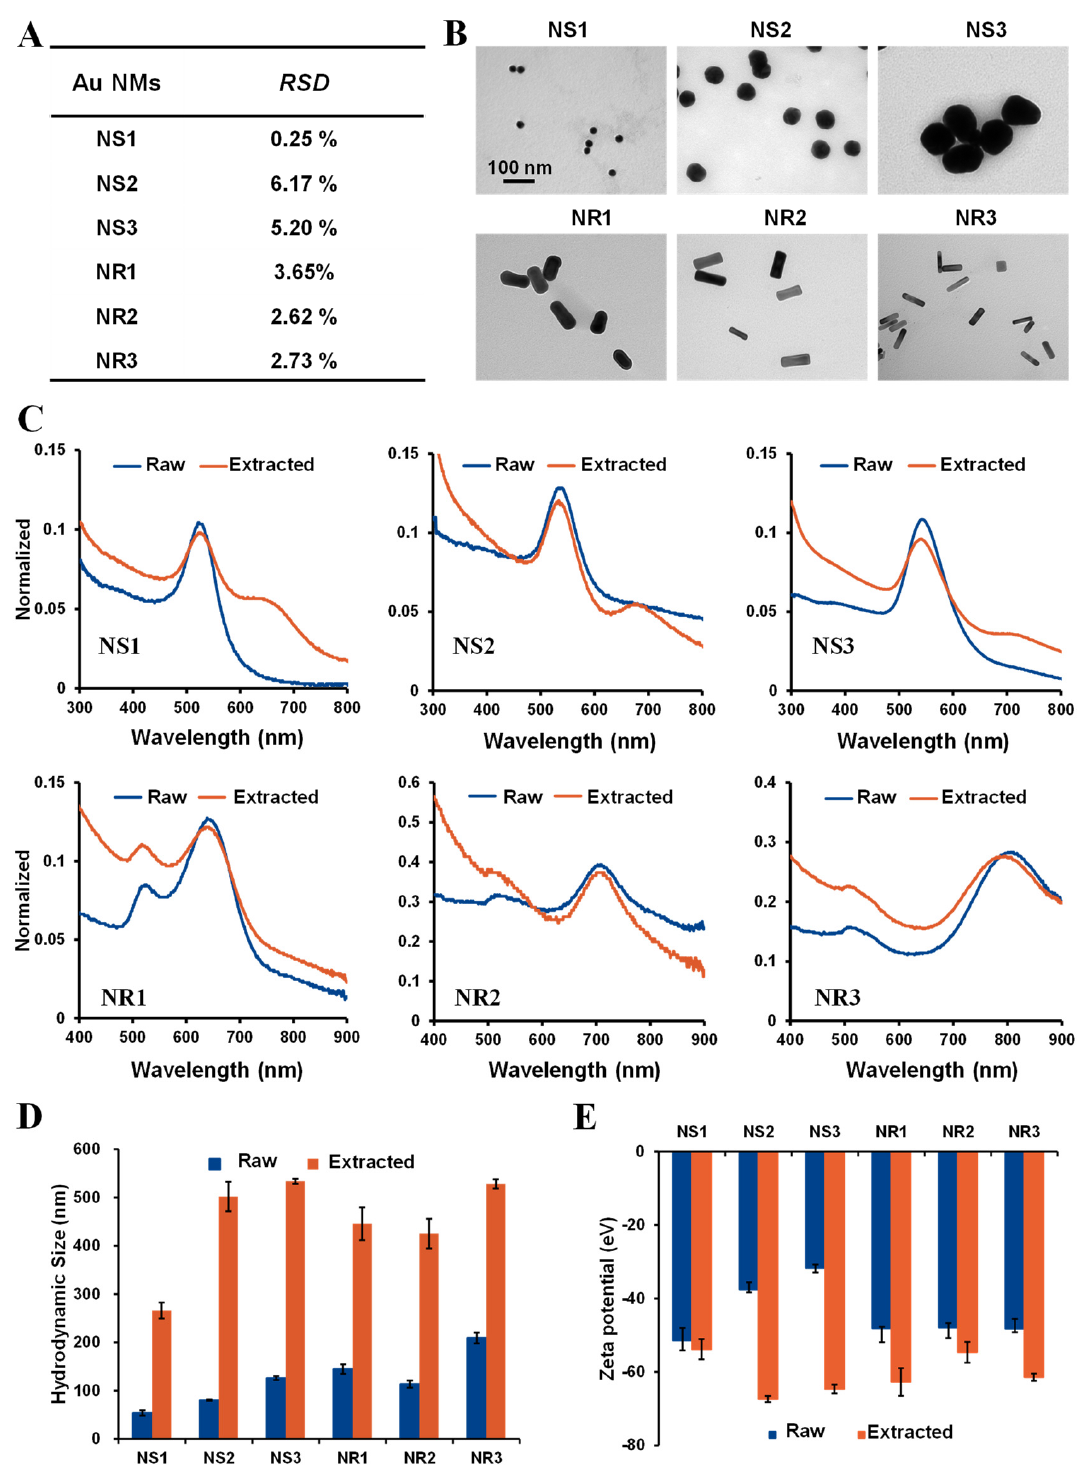
Figure 3. Physicochemical property comparison of Au NMs before and after extraction. ( A ) Homo- geneity assessment by RSD; ( B ) TEM images of extracted Au NMs; ( C ) comparison of UV − Vis − NIR spectrum of raw and extracted Au NMs; ( D ) comparison of the hydrodynamic size of raw and ex- tracted Au NMs; ( E ) comparison of the zeta potential of raw and extracted Au NMs.